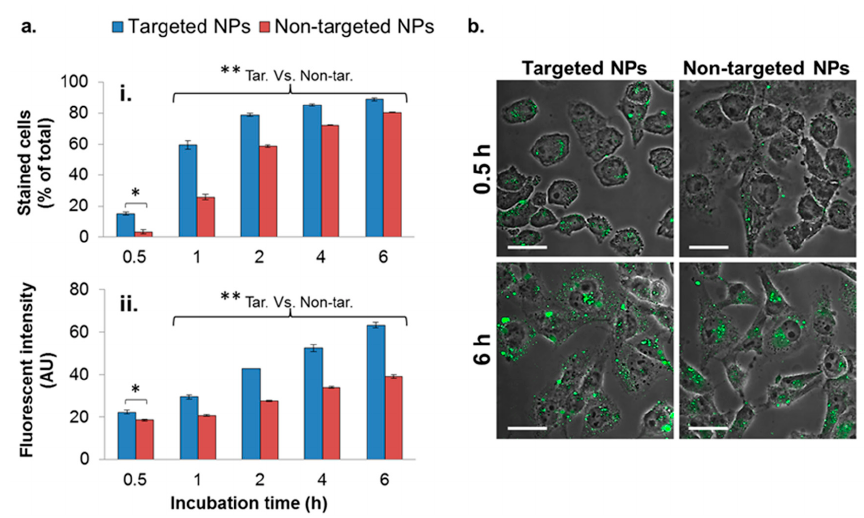
Figure 3. Cellular uptake of NPs by the MDA-MB-231 cell line. Cells internalizing NPs were analyzed quantitatively by means of flow cytometry (FACS) ( a ), and qualitatively by means of confocal laser scanning microscopy ( b ). A total of 10,000 cells were counted in each measurement ( n = 2). Data is presented as the mean ± SD, * p < 0.05 for targeted (Tar) versus non-targeted (Non-tar) at 0.5 h. ** p < 0.01 at 1, 2, 4, and 6 h for targeted versus non-targeted comparisons. NPs are shown in green (PLGA-BODIPY); magnification 60×; size bar, 30 µm. The fluorescent intensity was normalized to untreated cells.